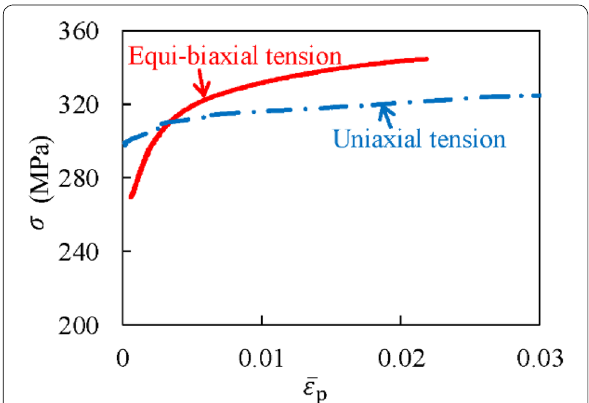
Figure 12 Comparison of σ vs. ε p curves from uniaxial and equi-biaxial tensile testing at 180 °C